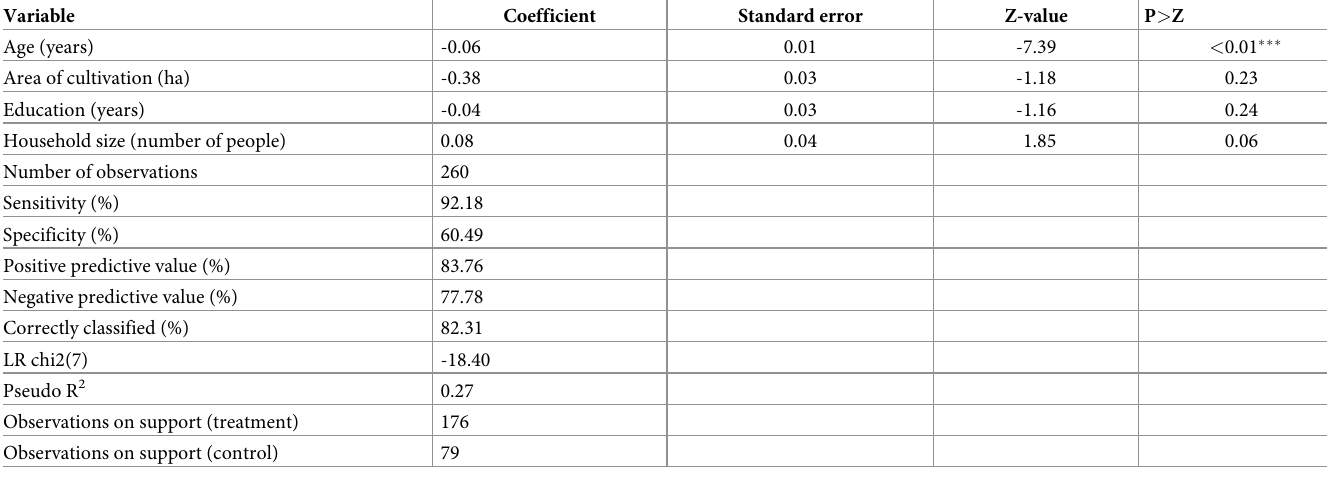
Table 4. Estimates from the PSM (treatment = good vision) with a probit model.